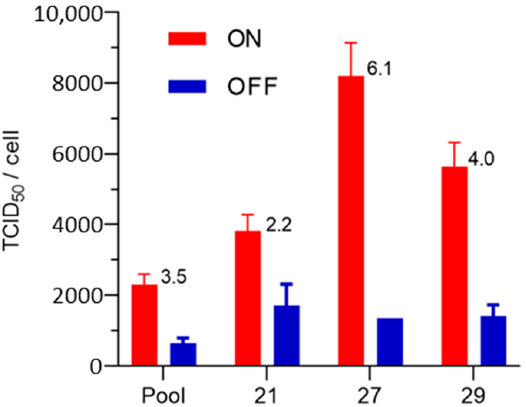
Figure 1. Production of AdPS- by the SF-BMAdR-CymR-PS pool and the 3 best clones (21, 27, and 29). Two wells of six-well plates for each subclone were infected with AdPS- using a MOI of 5 TCID 50 /cells in the presence or absence of the cumate ( n = 2). The specific productivity was measured by TCID 50 in duplicate and the ON/OFF ratio values are indicated above the bars. The data represent the mean ± SEM.